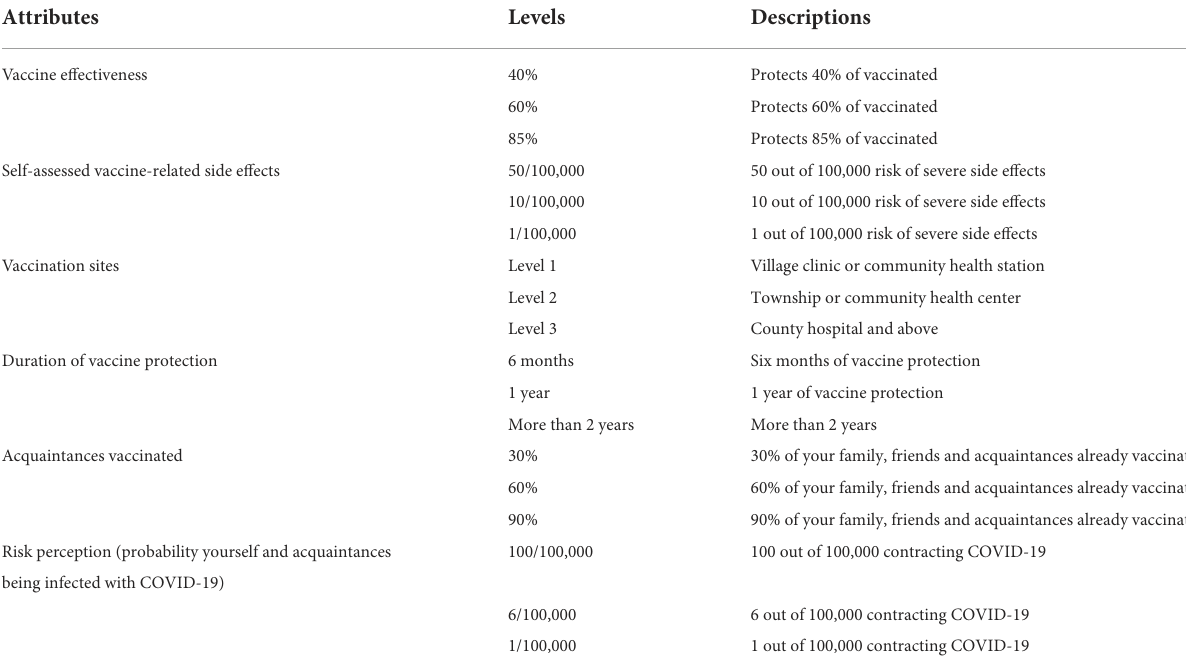
TABLE 1 Attributes and levels used in the discrete choice